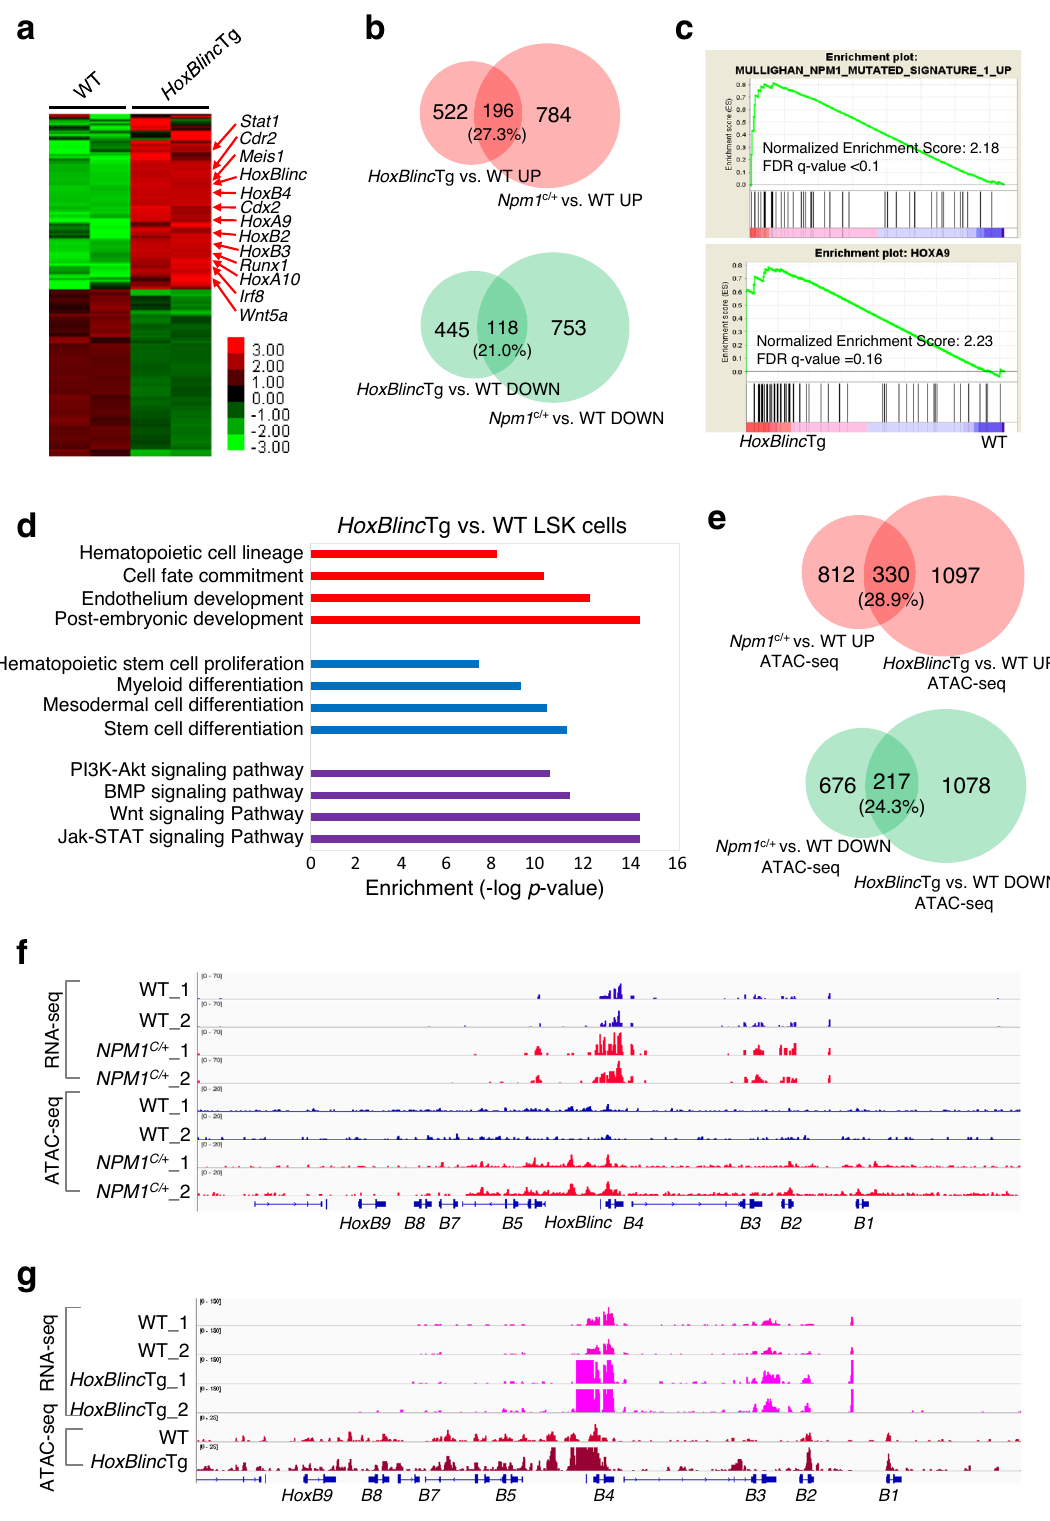
Fig. 4 Overexpression of HoxBlinc activates NPM1 c + signature genes via enhancing promoter chromatin accessibility in LSK cells. a Heatmap of RNA- seq analysis shows the up- and down-regulated genes in HoxBlinc Tg vs. WT LSK cells based on two independent experiments. Red arrows: up-regulated genes implicated in HSPC regulation/leukemogenesis. b Overlap of up- ( top ) or down- ( bottom ) regulated genes between HoxBlinc Tg vs. WT and NPM1 c/ + vs. WT LSK cells. c Enrichment of upregulated genes involved in NPM1 -mutated signature ( top ) and HOXA9 ( Bottom ) oncogenic pathway upon overexpression of HoxBlinc in LSK cells by GSEA. d The HoxBlinc overexpression dysregulated genes in LSK cells were analyzed and annotated by GO analysis. e Overlap of global gain ( top ) or loss ( bottom ) of promoter chromatin accessibilities between ATAC-seq data of HoxBlinc Tg vs. WT and NPM1 c/ + vs. WT LSK cells. f RNA-seq (chromatin accessibility, top 4 tracks ) and ATAC-seq (gene expression, bottom 4 tracks ) analysis of WT and Npm1 c/ + LSK cells in the HoxB gene locus. g RNA-seq analysis ( top 4 tracks ) and ATAC-seq analysis ( bottom 2 tracks ) of WT and HoxBlinc Tg LSK cells in the HoxB gene